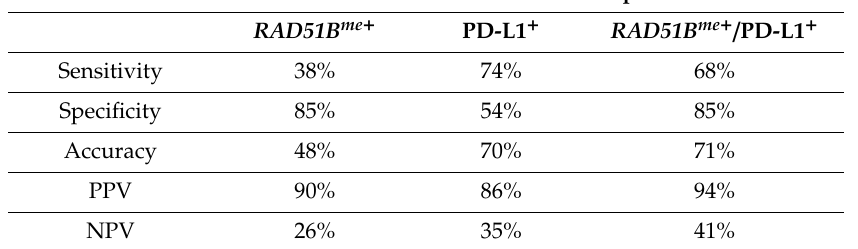
Table 3. RAD51B me , PD-L1 staining and the combination of the two variables performances as predictive biomarkers of PD-1 blockade response in the Treated Cohort